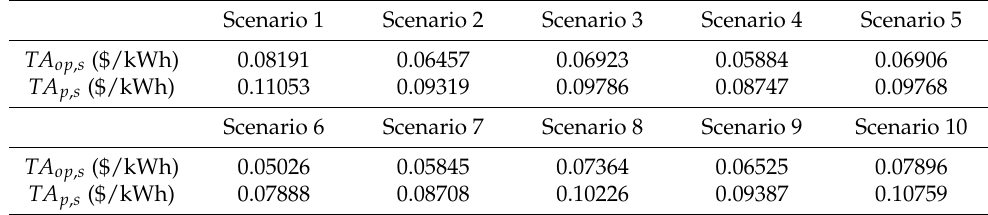
Table 3. Tariff scenarios for the green flag.